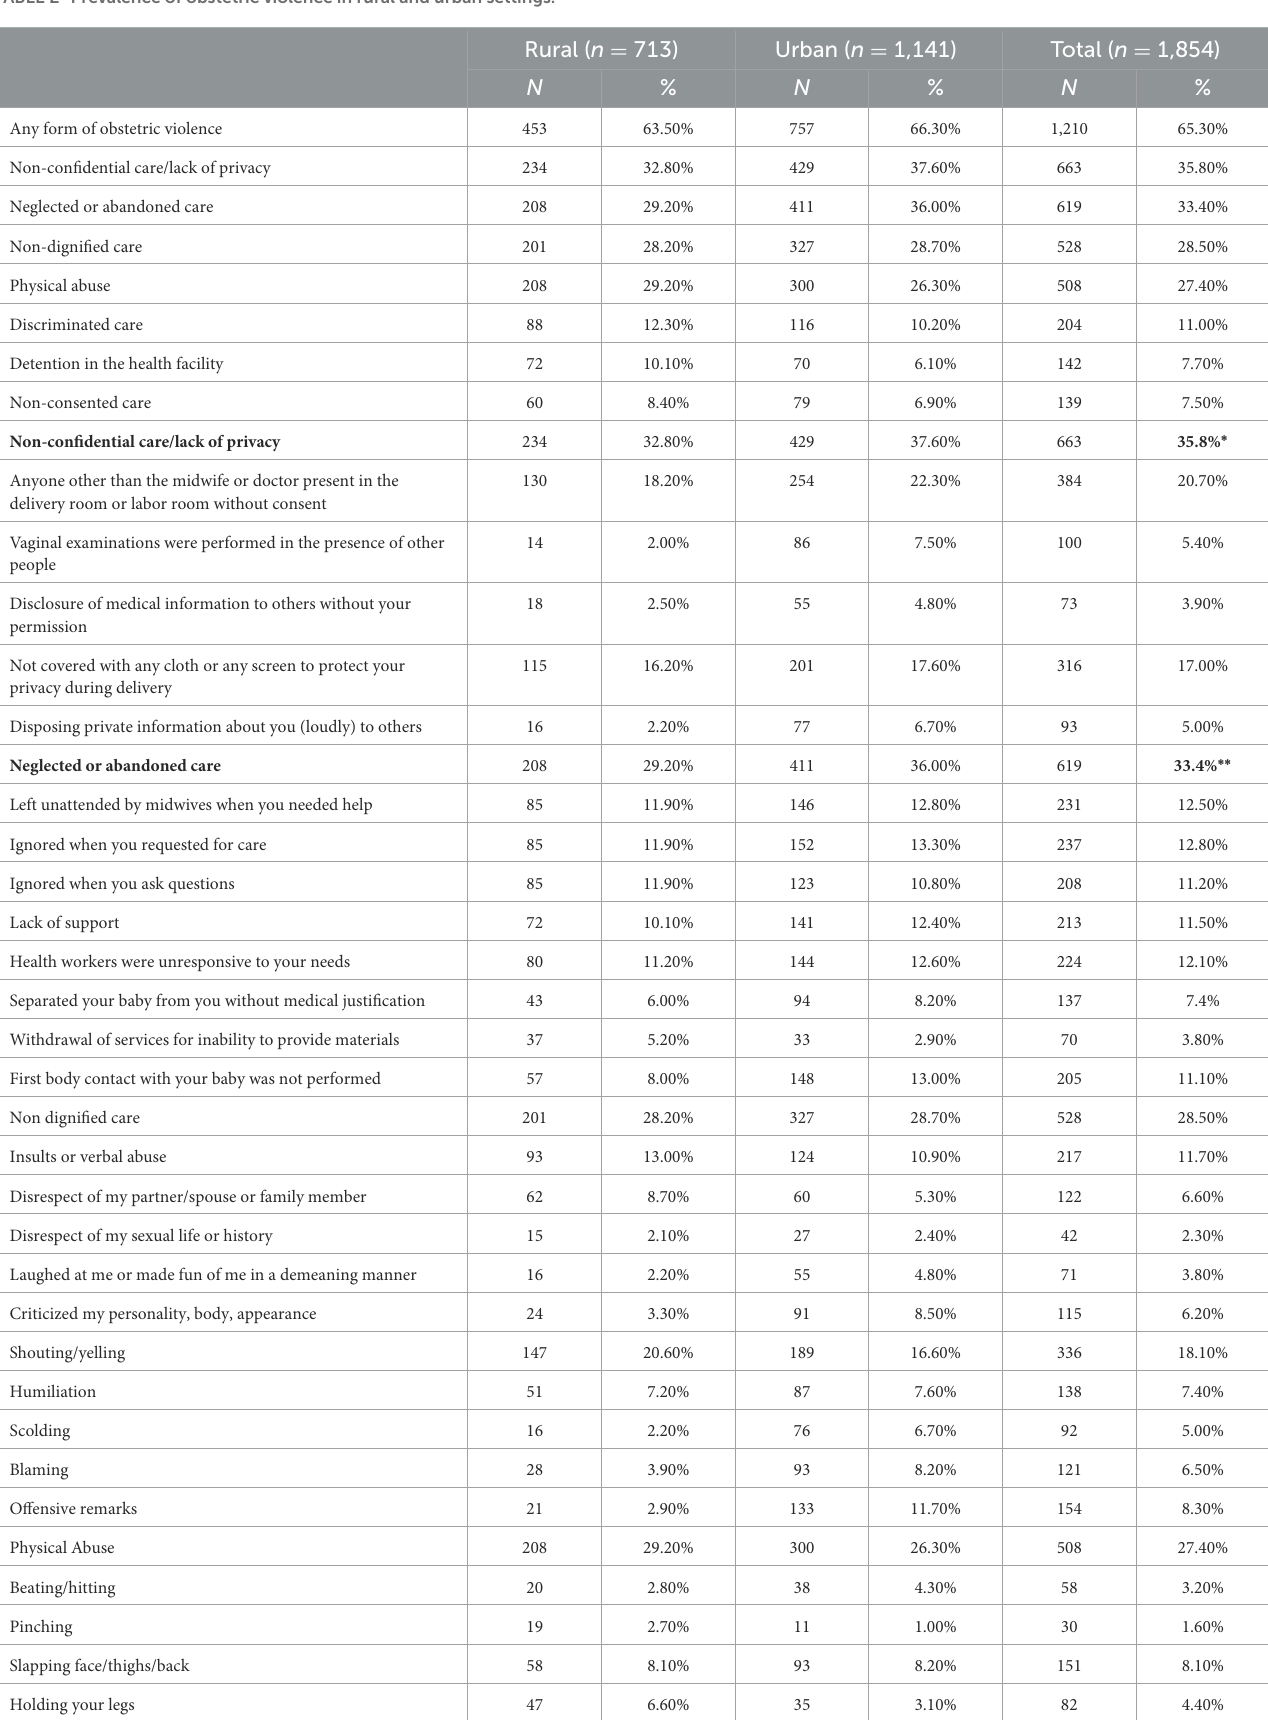
TABLE 2 Prevalence of obstetric violence in rural and urban